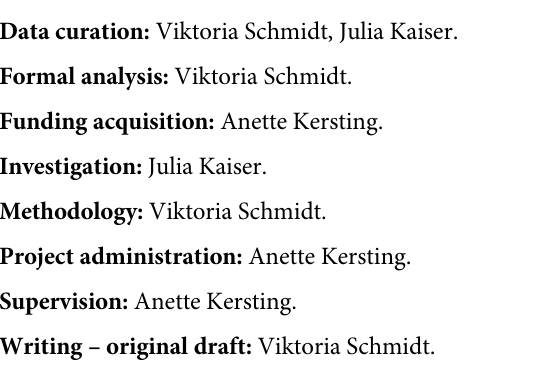
S6 Table. Correlation matrix of all variables included in the best subset